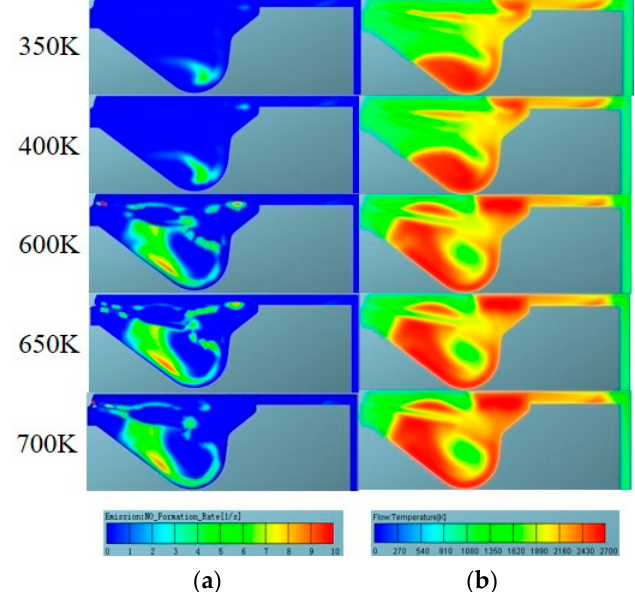
Figure 10. NO production rate and temperature at 730° CA. (a) Comparison of diffusion rate at 730° CA; (b) Temperature distribution at 730° CA.